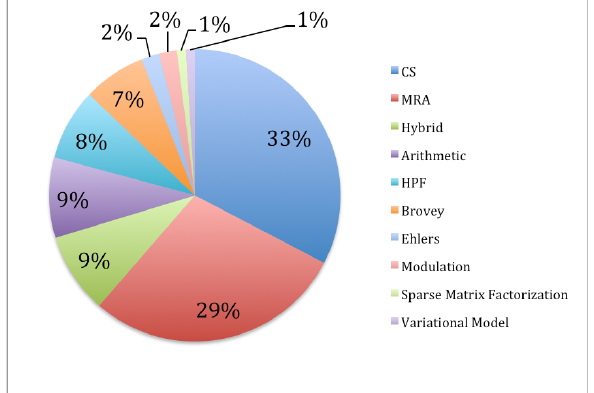
Figure 3. Popularity of algorithms from journal publications